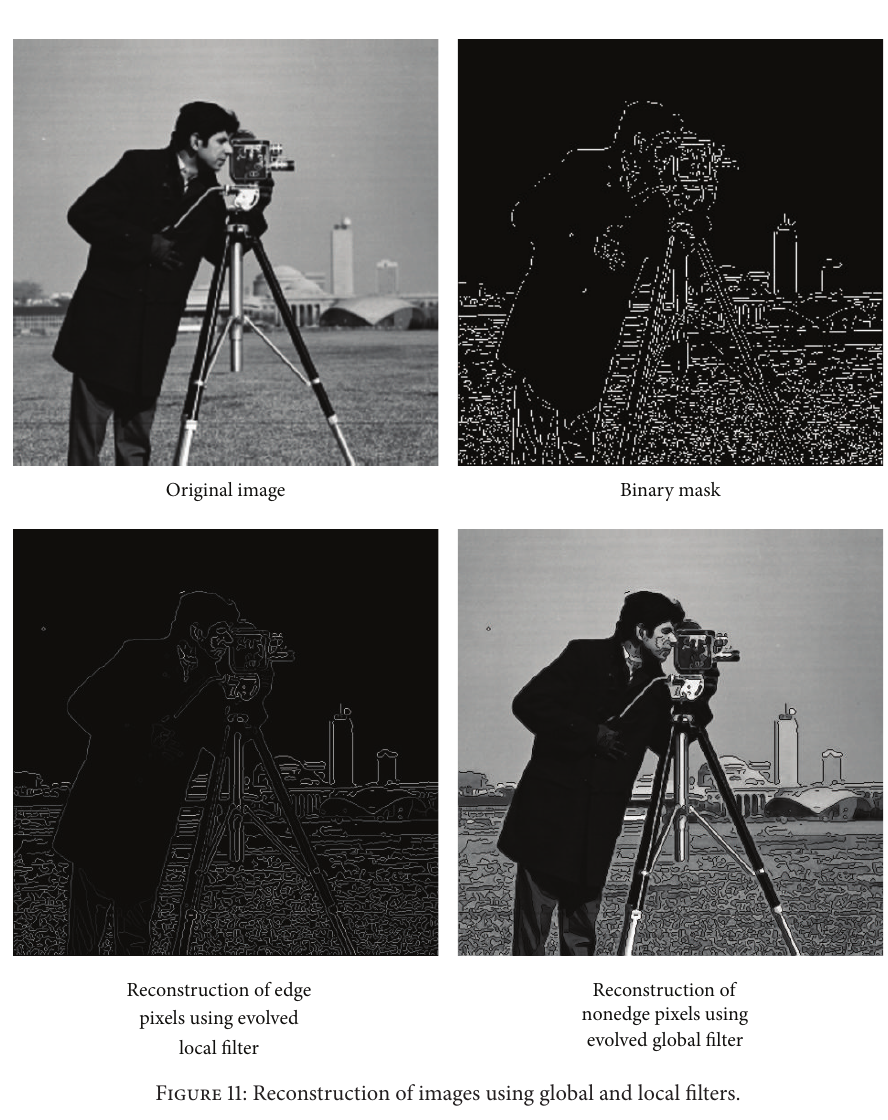
Figure 11: Reconstruction of images using global and local